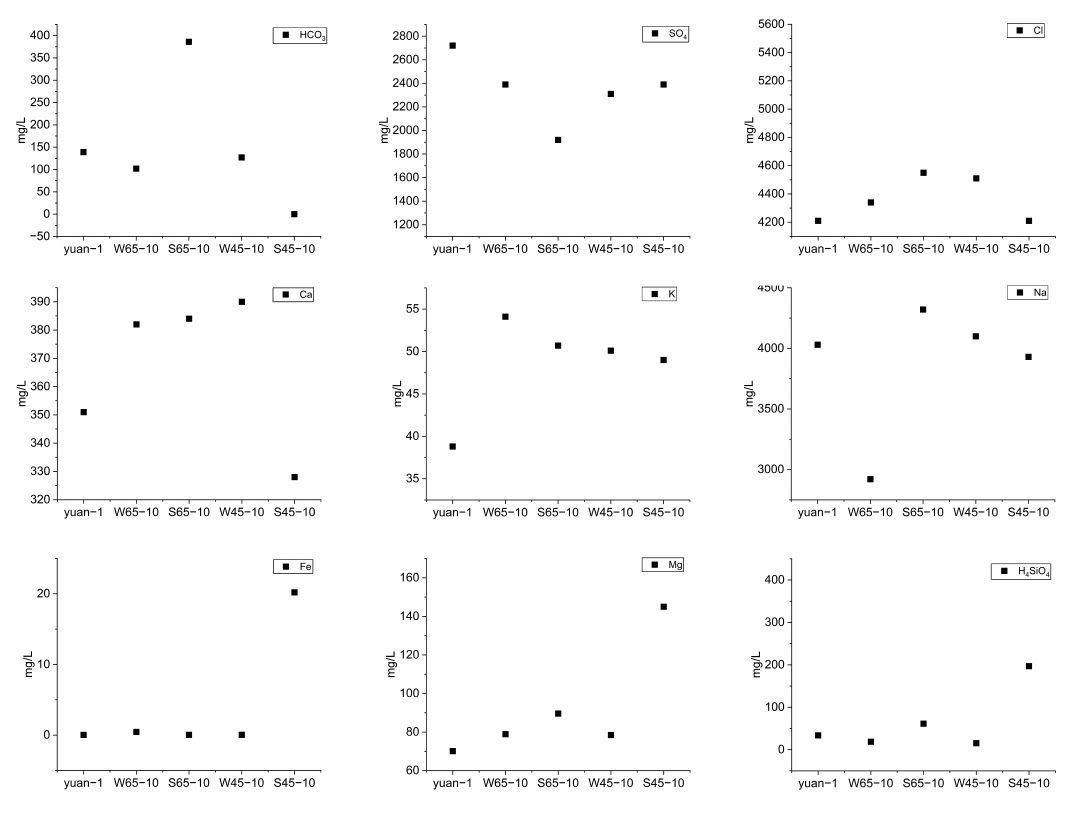
Figure 7. Comparison of elemental composition in geothermal water under different temperature conditions.